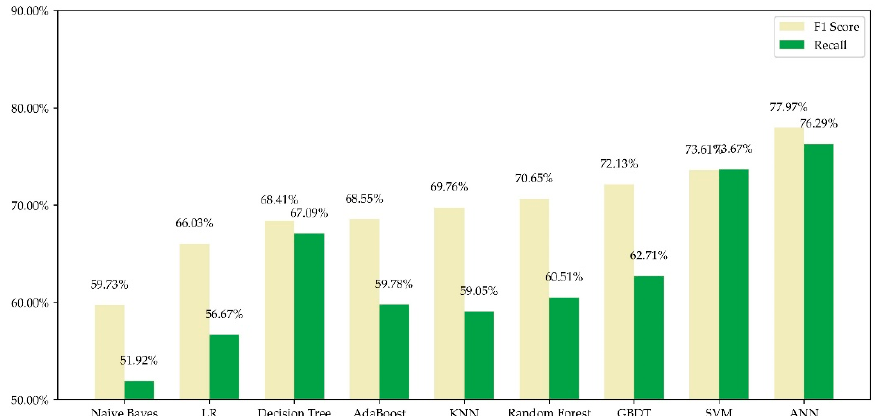
Figure 4. F1 score and recall of different machine learning algorithms on our dataset. ANN performs best among the classical algorithms. Note that the results were obtained through 300 repeated tests and the mean value was employed. The result of ANN was acquired through the architecture of two hidden layers with both 50 neurons.